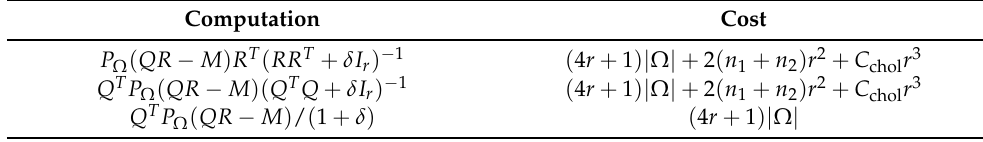
Table 1. Computational costs of the gradients of the objective function.